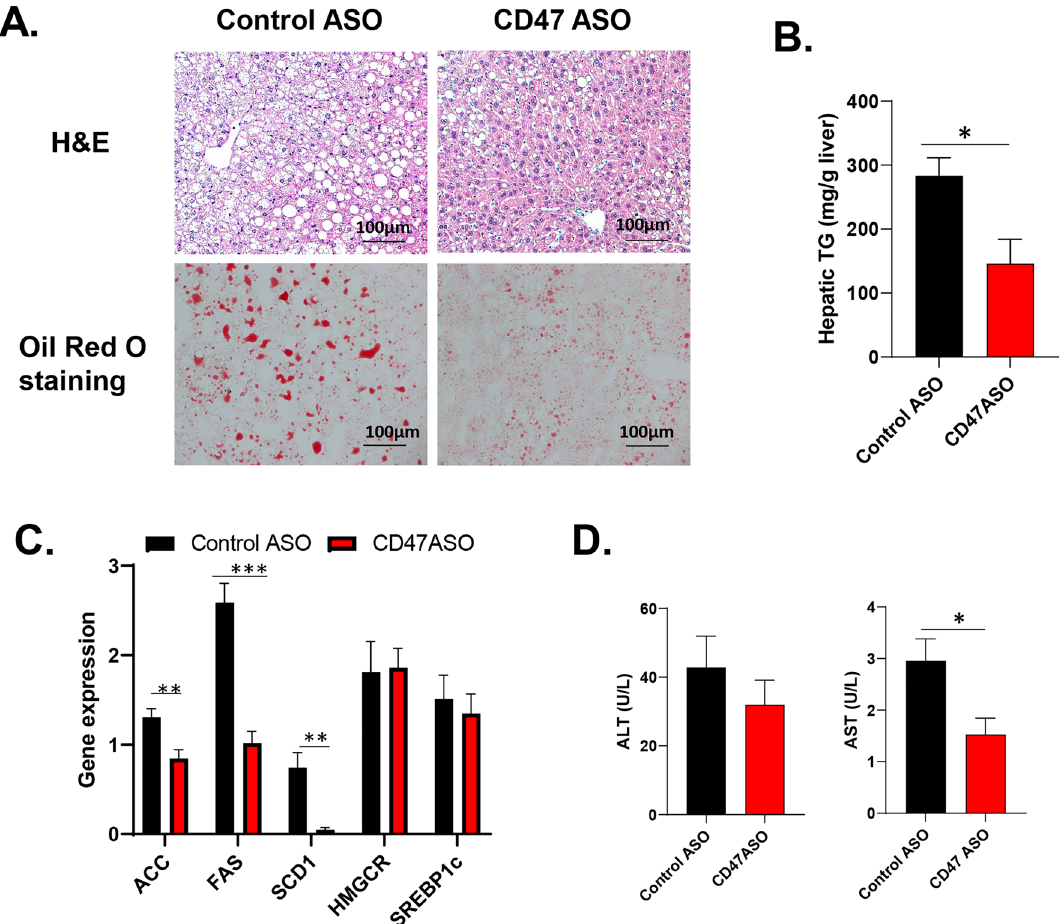
Figure 3. CD47ASO treatment reduced hepatic steatosis in diet-induced obese mice. ( A ) Representative H&E staining and Oil red O staining of liver sections from control ASO or CD47 ASO treated mice; ( B ) Liver triglyceride levels; ( C ) Liver gene expression by qPCR; ( D ) Plasma ALT and AST levels. Data are represented as mean ± SE (n = 4–7 mice/group). * P < 0.05, ** P < 0.01, *** P <